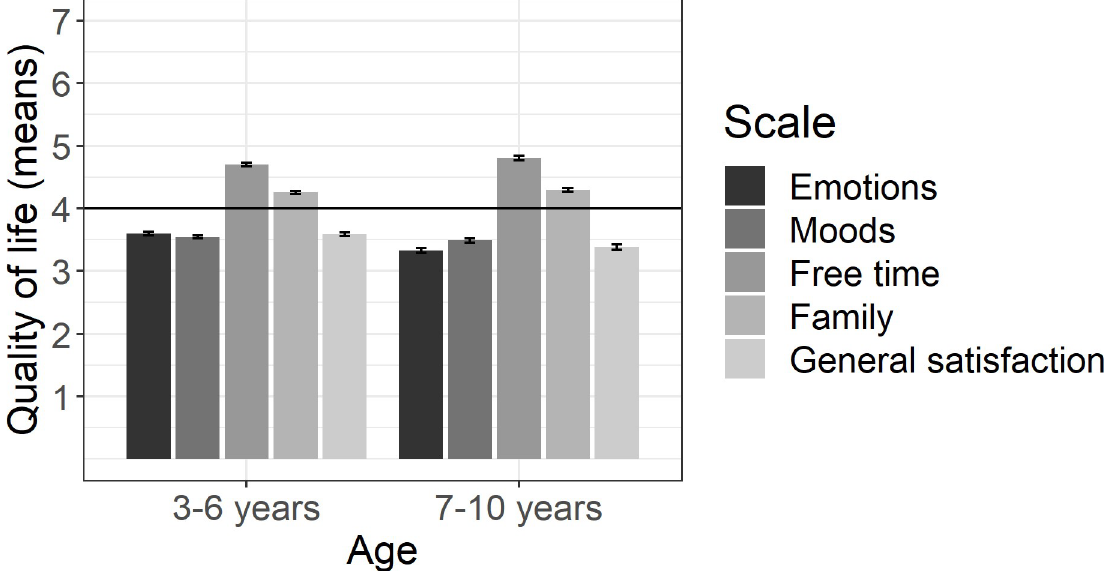
Fig 6. Changes in children’s situation in comparison to the situation before the pandemic and the associated restrictions split by children’s age. Error bars represent standard